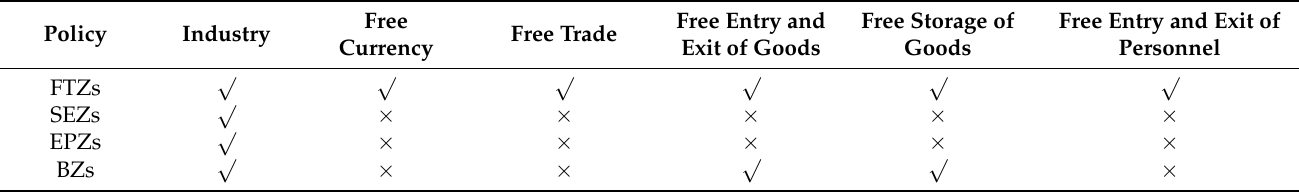
Table 1. Comparison between FTZs and other policy